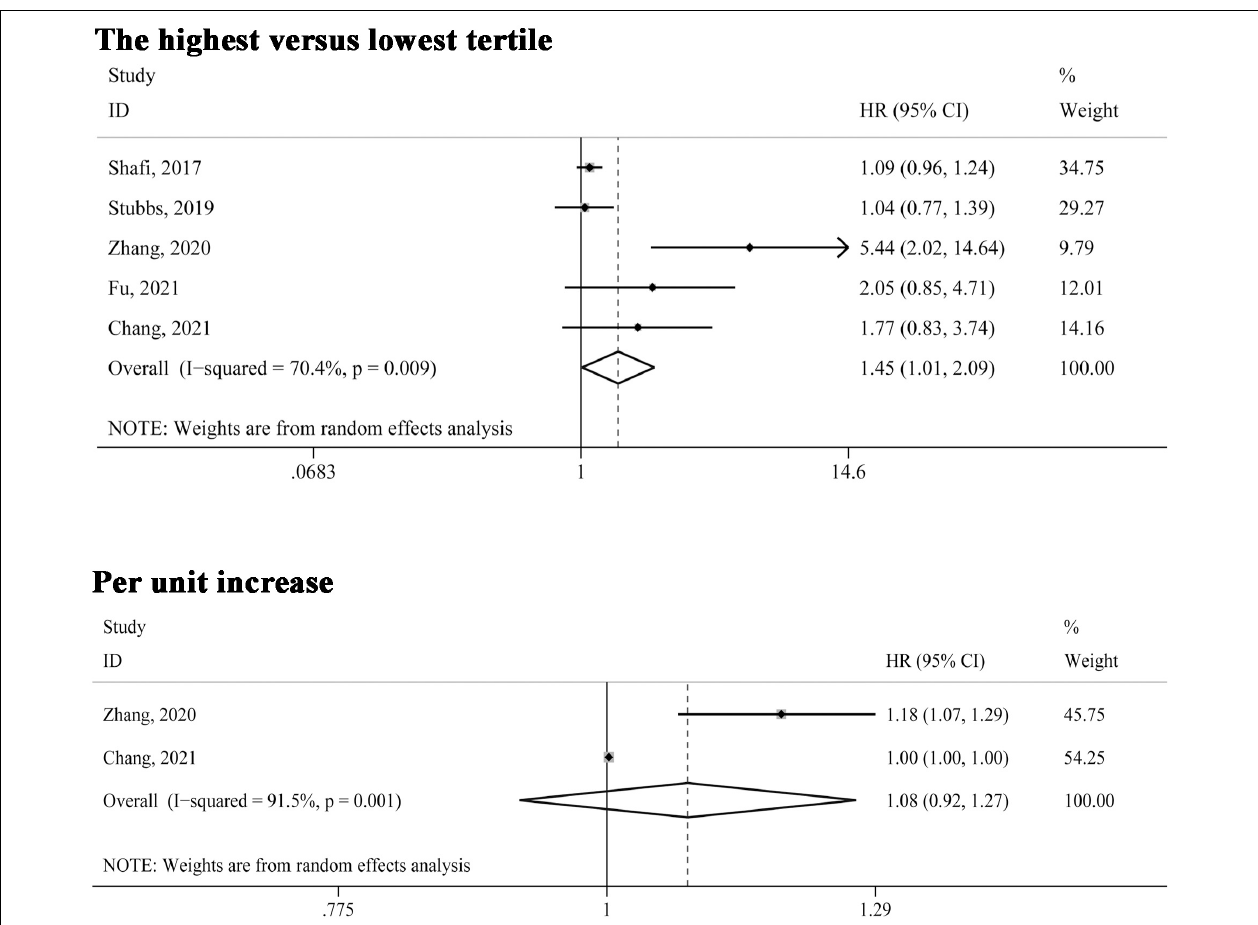
FIGURE 3 | Forest plot of the highest versus lowest tertile and per unit increase in TMAO levels and cardiovascular mortality risk. HR, hazard risk; CI, confidence